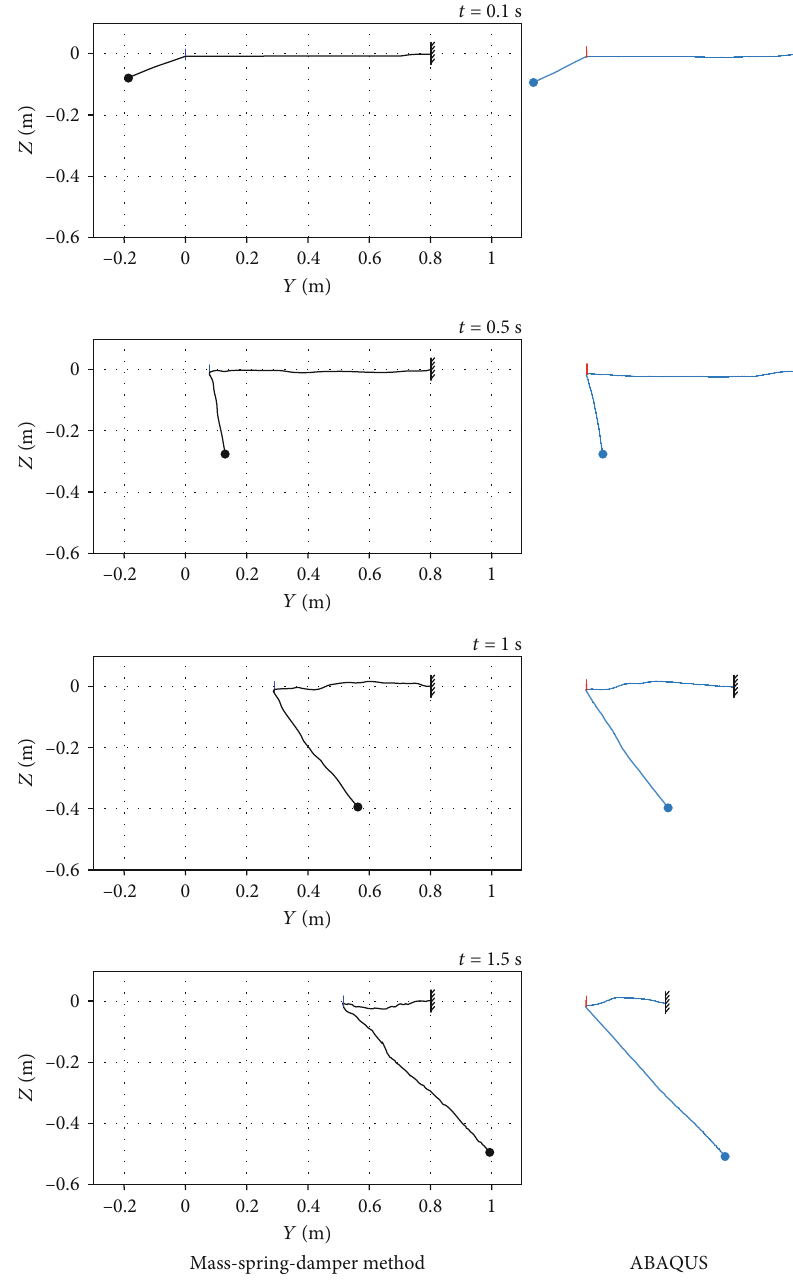
Figure 7: Comparison of simulation